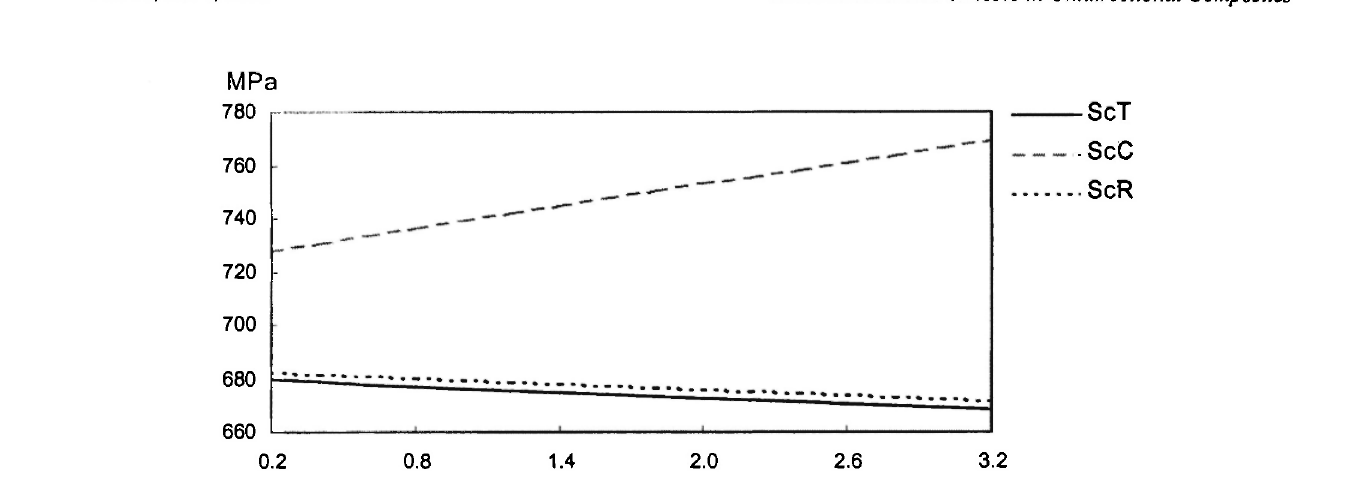
Fig. 8: Effect of thermal expansion coefficients of fiber on maximum absolute stress of coating for composites reinforced with a transversely isotropic fiber